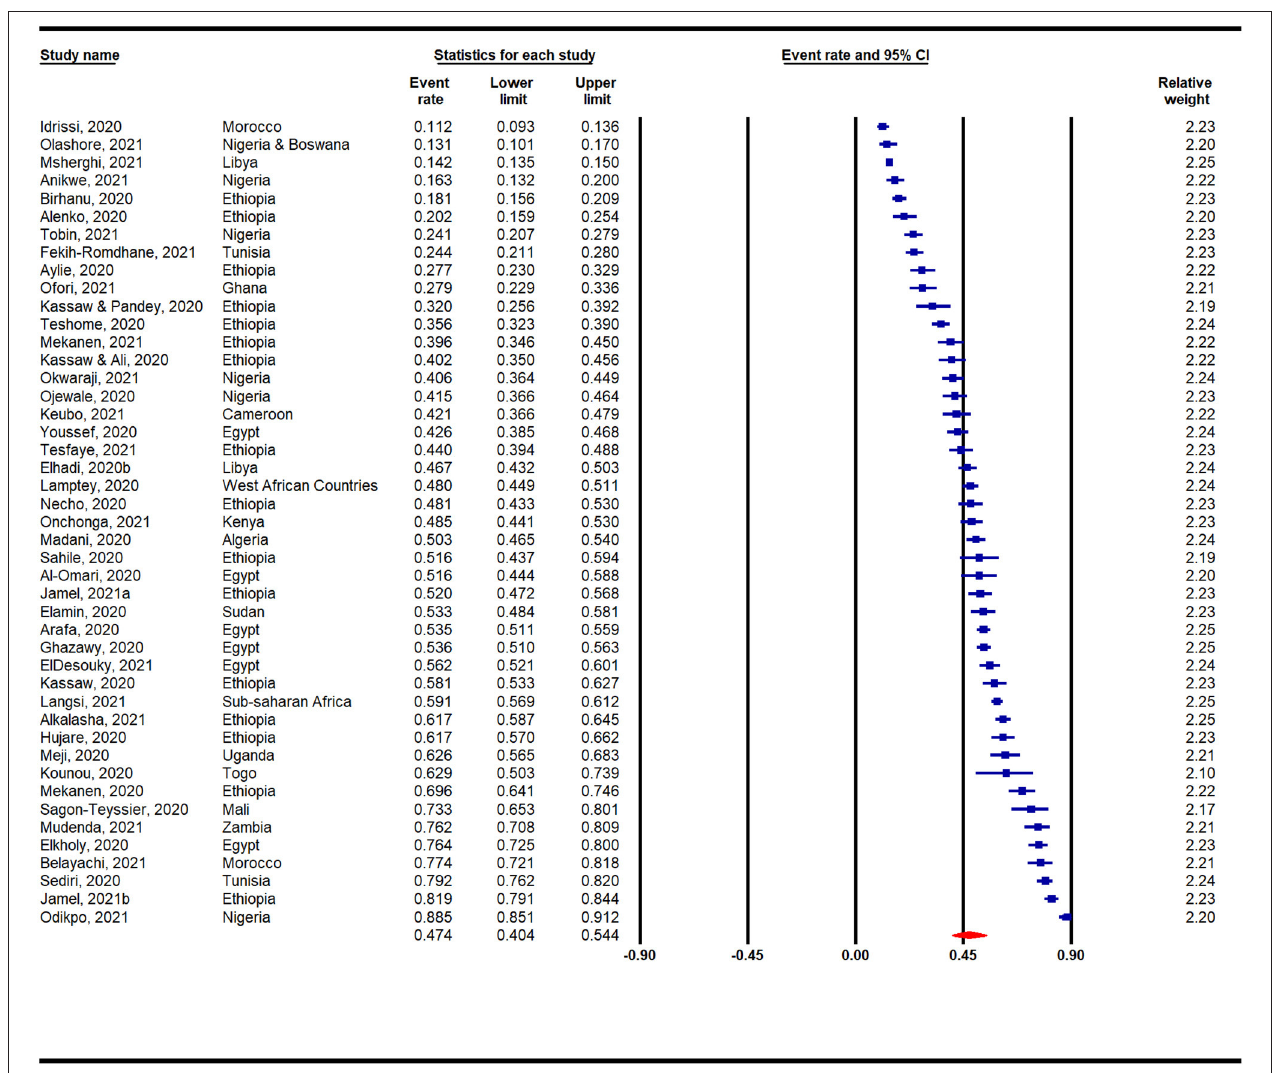
FIGURE 2 | Overall prevalence of anxiety in Africa during the COVID-19 pandemic.